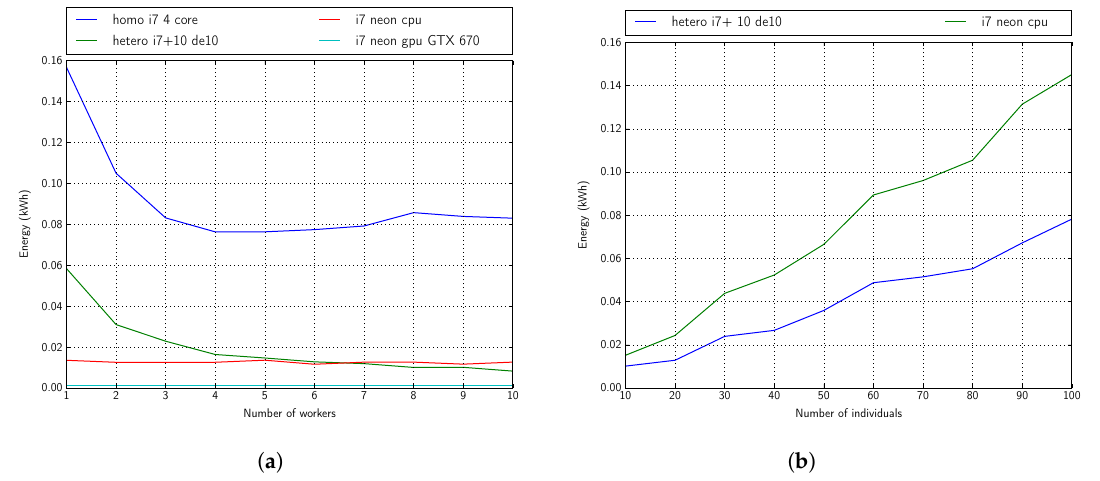
Figure 10. Energy consumption: three generations for the i7 platform. ( a ) Fixed number of individuals: 16; ( b ) fixed number of workers: 10.